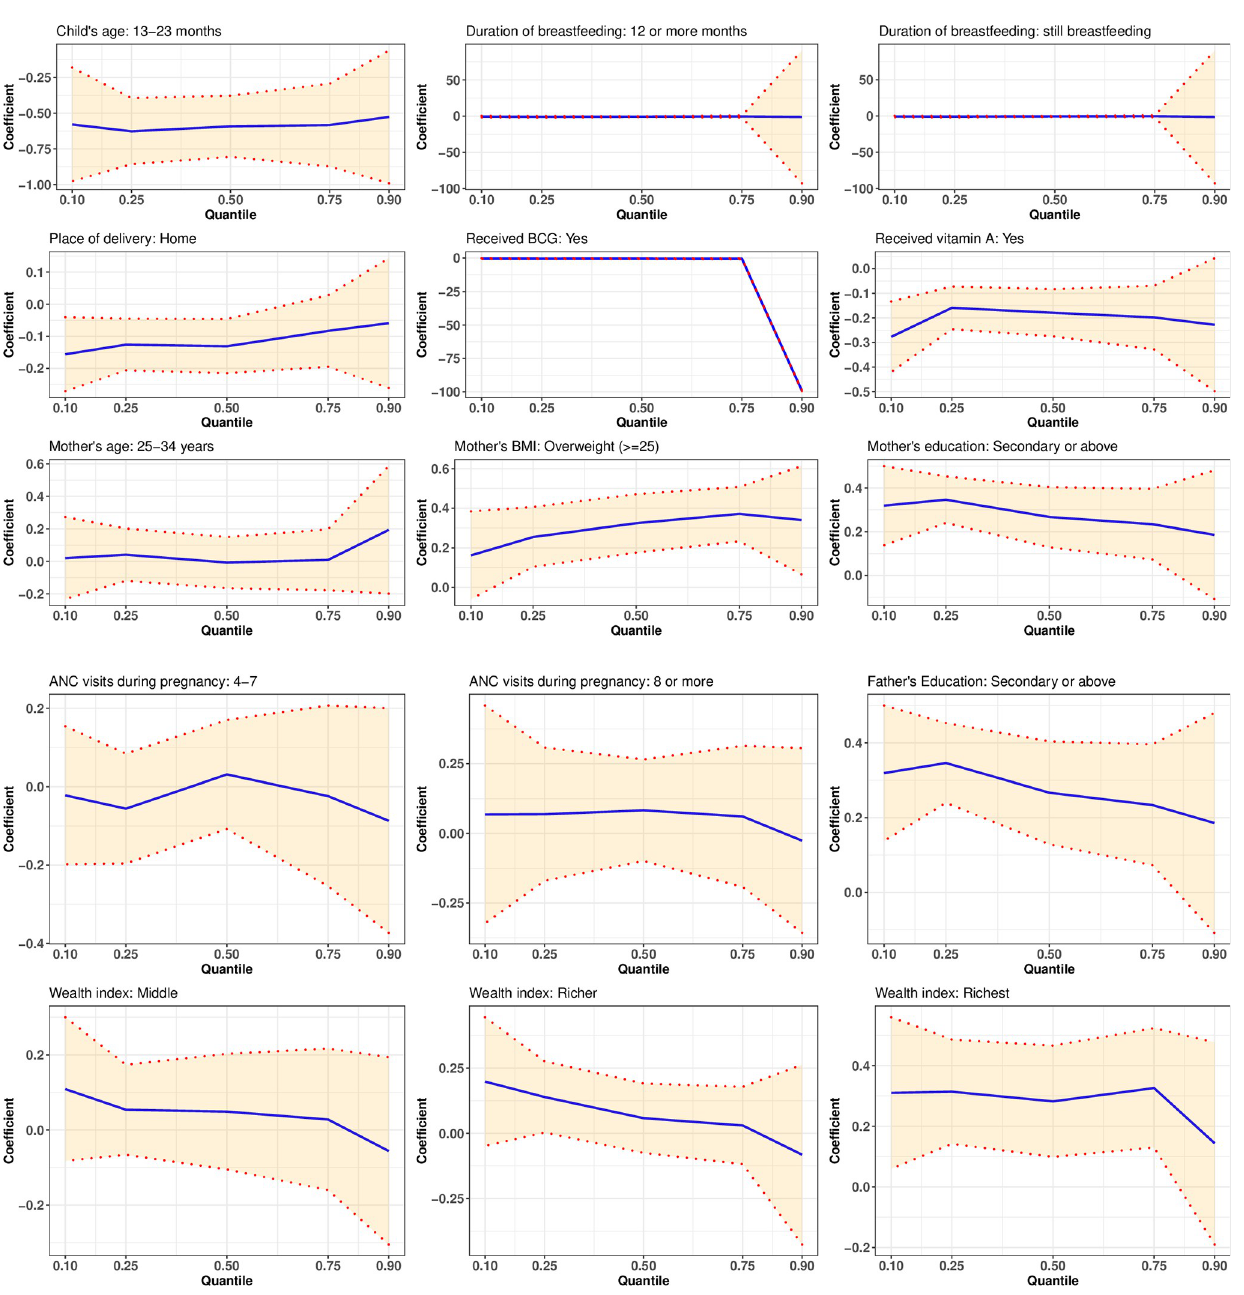
Fig 2. Elasticity (95% confidence interval) of the significant estimates at all considered quantiles.